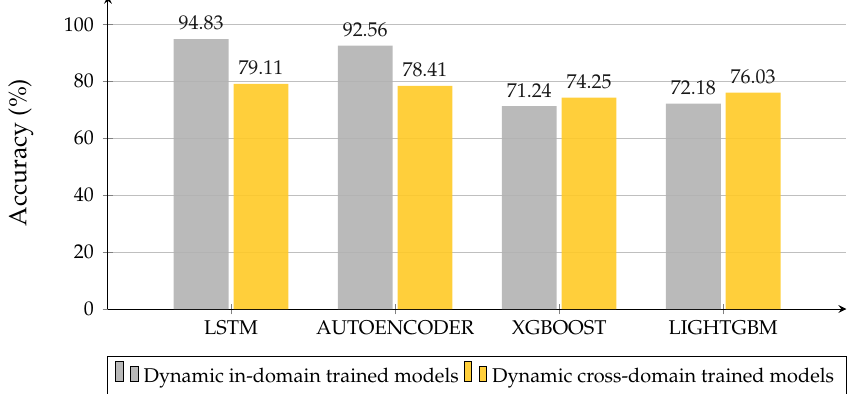
Figure 13. Comparison of best models trained on raw data—Cross-Domain